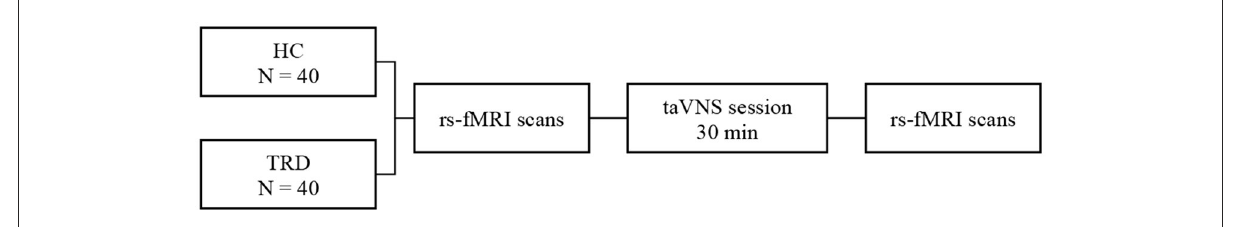
FIGURE2 fMRI for instant taVNS were measured before and after the first treatment on the two groups.